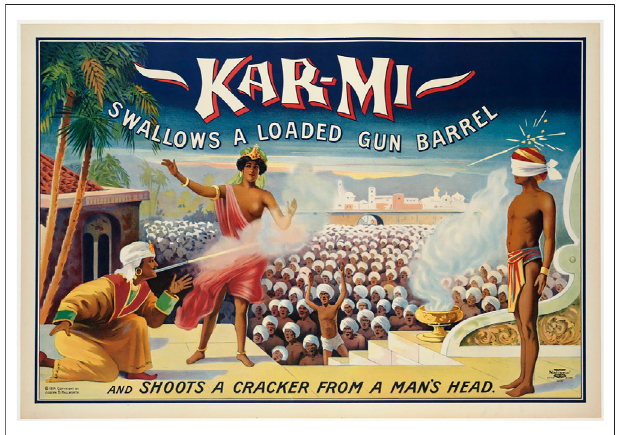
FIGURE1| 1914postersuggestingwhatKar-Mi ’ saudienceweremade to believe. Original held at Boston Library. Reproduced from the Massachusetts Collection Online under Creative Commons